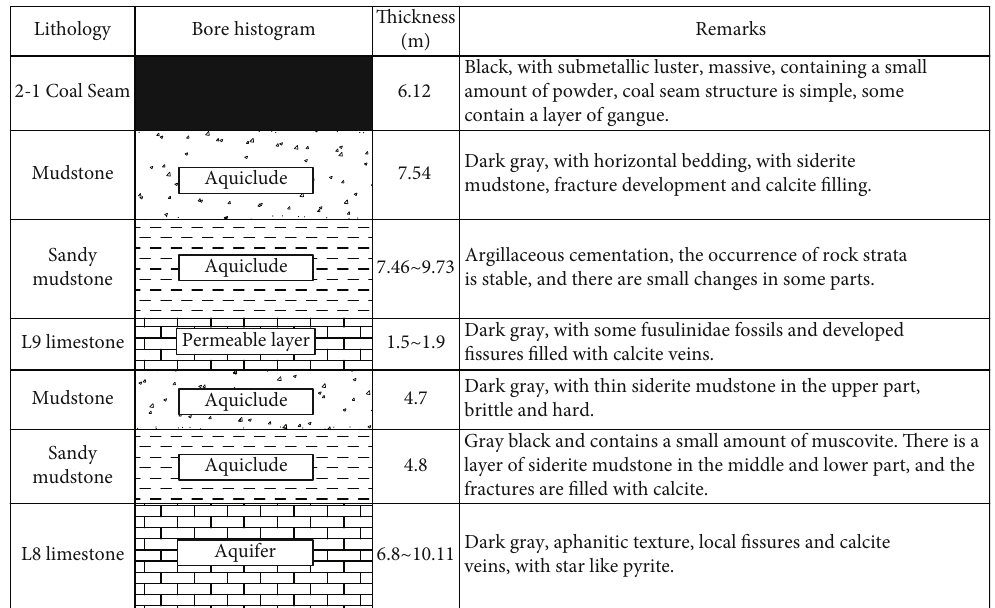
Figure 1: The comprehensive histogram of rock strata in coal seam.